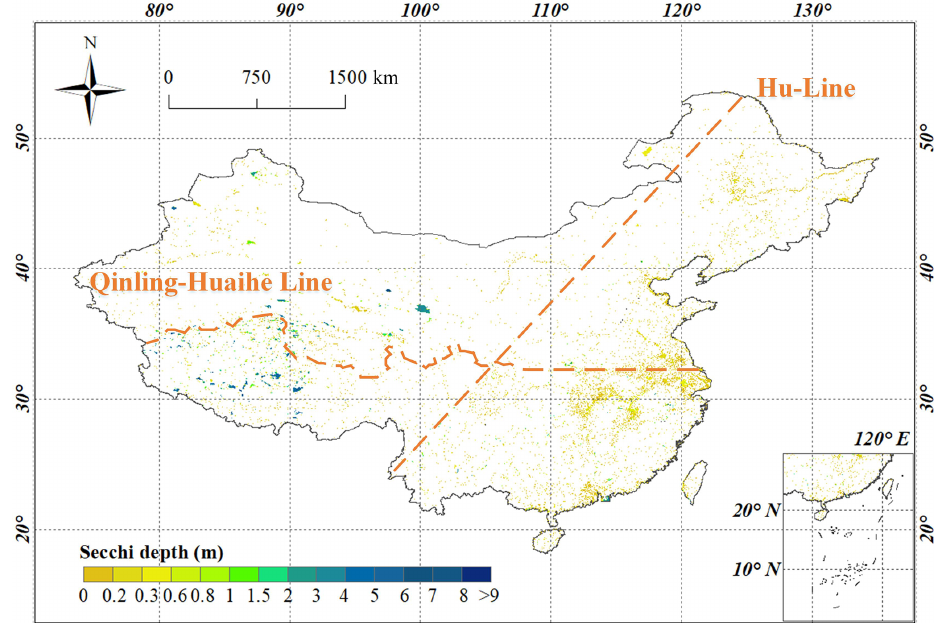
Figure 5. The 30m SD product in China in 2019. Note: the north–south dashed line is the Hu Line, inherited from Hu (1990) and the east–west dashed line is the Qinling–Huaihe Line, inherited from Liu et al.